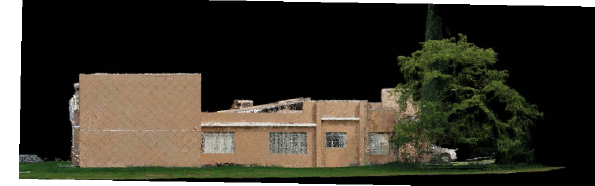
Figur e 9: West facade with photogrammetry tool.